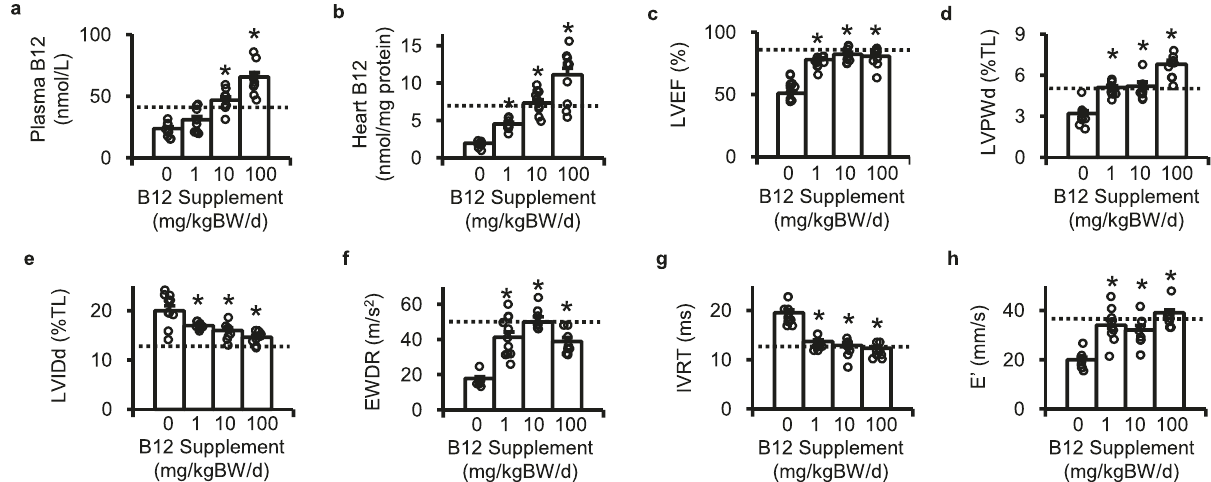
Fig. 1 Oral high-dose cyanocobalamin (B12) prevents diabetic cardiomyopathy. B12 was supplied to the Elmo1 H/H Ins2 Akita/ + mice in drinking water to achieve estimated daily intake of 0, 1, 10 and 100 mg/kg body weight (BW). a Plasma levels of B12. b Cardiac levels of B12. c Ejection fraction of the left ventricles (LVEF). d Left ventricular posterior wall thickness in diastole (LVPWd). e Internal diameter of the left ventricle in diastole (LVIDd). f E-wave deceleration rate (EWDR) of the mitral fl ow. g Isovolumic relaxation time (IVRT) of the left ventricle h Early tissue Doppler velocity (E ’ ). Data are expressed as means ± standard errors. Nine to ten mice were in each group. * P < 0.05 vs. mice with non-supplemented drinking water by Tukey – Kramer Honestly Signi fi cant Differences test after one-way ANOVA. LVPWd and LVIDd were normalized by tibia length (TL). Dotted lines in the fi gures indicate average levels in non-diabetic Elmo1 H/H Ins2 + / + mice.